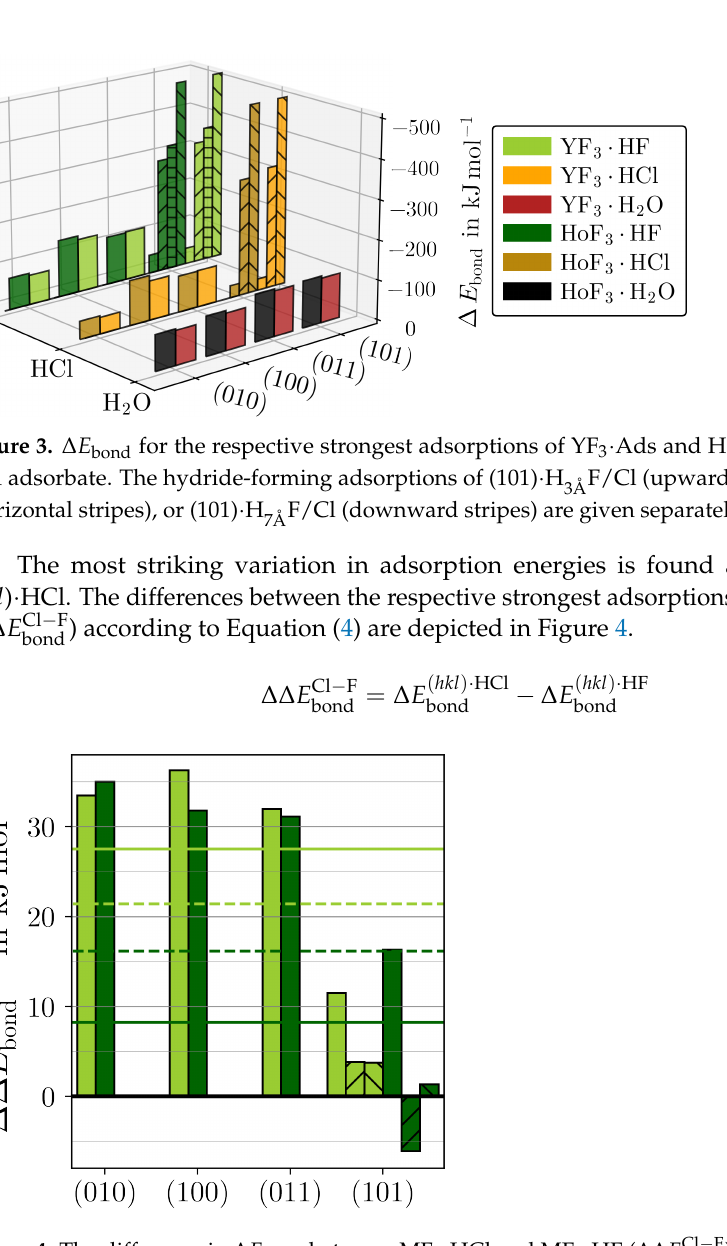
Figure 4. The difference in ∆ E bond between MF 3 · HCl and MF 3 · HF ( ∆∆ E Cl − F ) (see Equation (4)) for bond M = Y (light green) and M = Ho (dark green) is given for the respective strongest adsorption of each ( hkl ) (bars) and as the average overall ( hkl ) with (solid lines) or without the hydride-forming adsorptions (dashed lines) of (101) · H F/Cl (upward stripes) or (101) · H F/Cl (downward 3Å 7Å